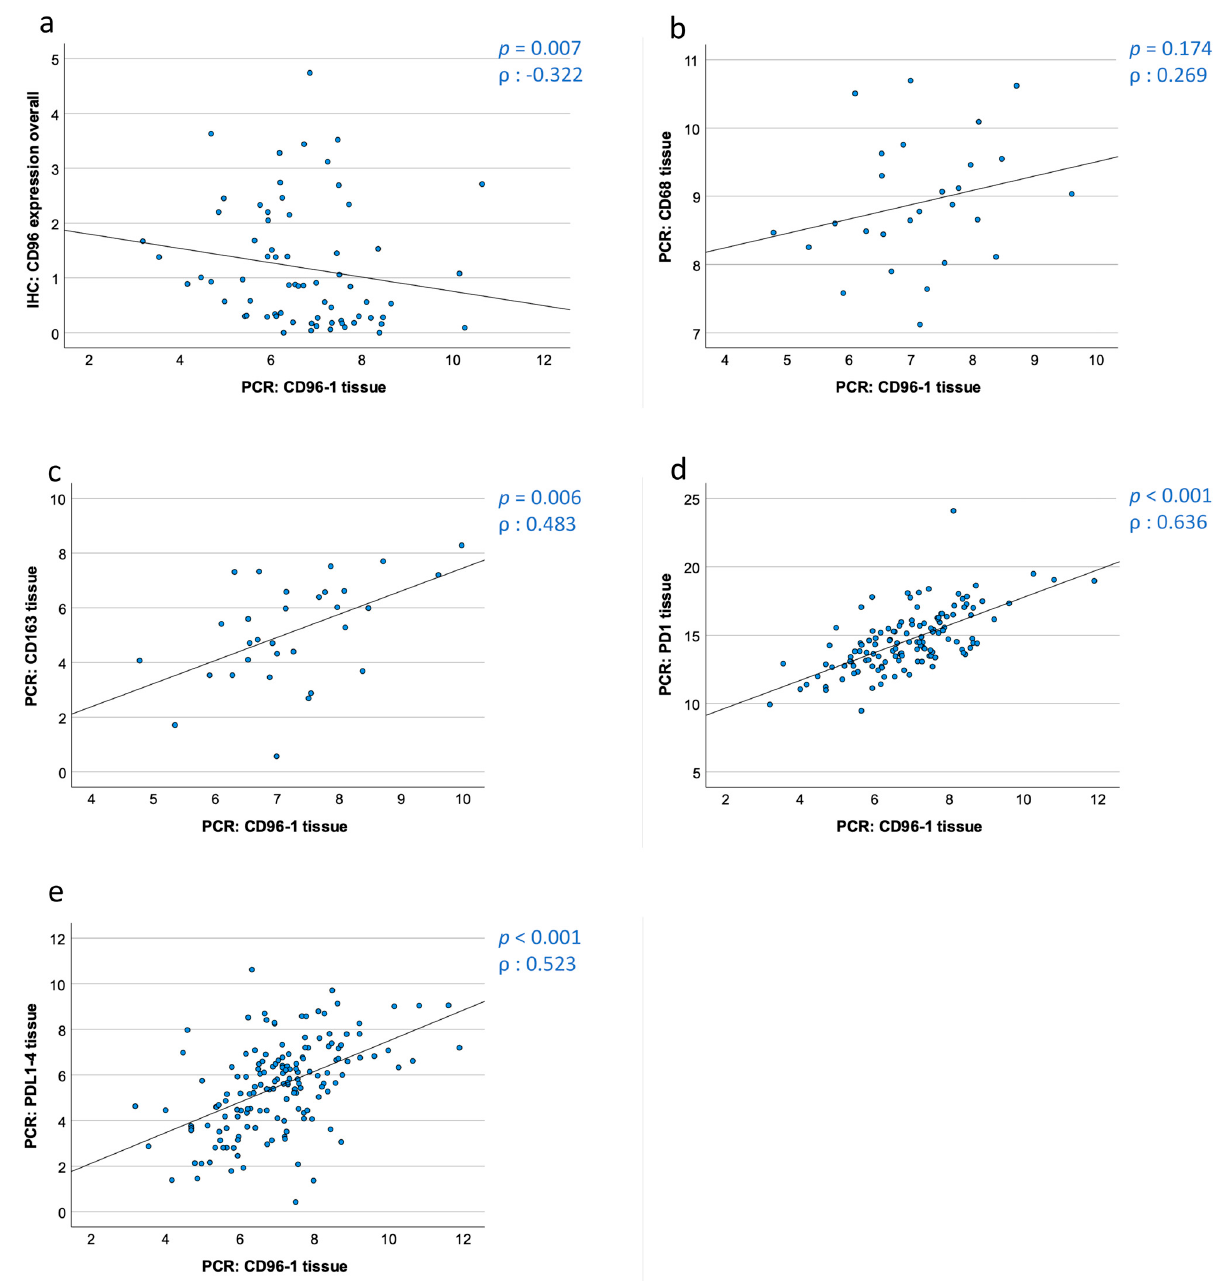
Figure 5. Correlation of CD96 mRNA and protein expression and correlation of CD96 expression with macrophage markers and the PD-L1/PD1 immune checkpoint in tissue samples. The scatter diagrams show the correlation between CD96 mRNA and protein expression ( a ) as well as the correlation of ∆ CT values of CD96 (transcript variant 1) with CD68, CD163, PD1, and PD-L1 (transcript variant 4) derived by RT-qPCR analysis ( c – e ). Spearmen correlation coefficients ( ρ ) and the p -values are indicated. ( a ) Correlation of CD96 protein expression provided by immunohistochemistry and CD96 mRNA expression (transcript variant 1) provided by RT-qPCR. ( b ) Correlation of CD96 mRNA expression (transcript variant 1) and CD68 mRNA expression provided by RT-qPCR. ( c ) Correlation of CD96 mRNA expression (transcript variant 1) and CD163 mRNA expression provided by RT-qPCR. ( d ) Correlation of CD96 mRNA expression (transcript variant 1) and PD1 mRNA expression provided by RT-qPCR. € Correlation of CD96 mRNA expression (transcript variant 1) and PD-L1 (transcript variant 4) mRNA expression provided by